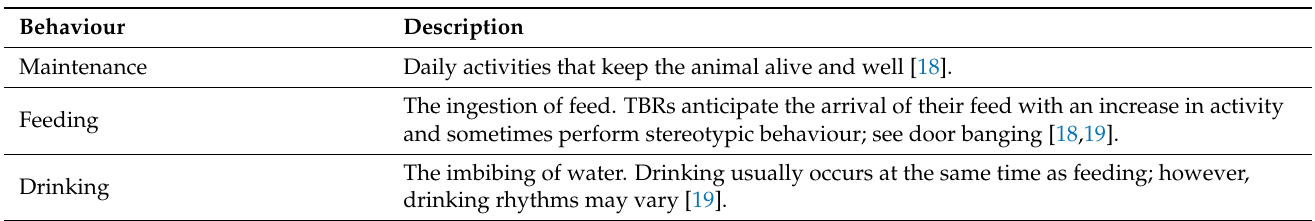
Table 1. Definitions of behaviours in observations of Thoroughbred racehorses ( Equus caballus